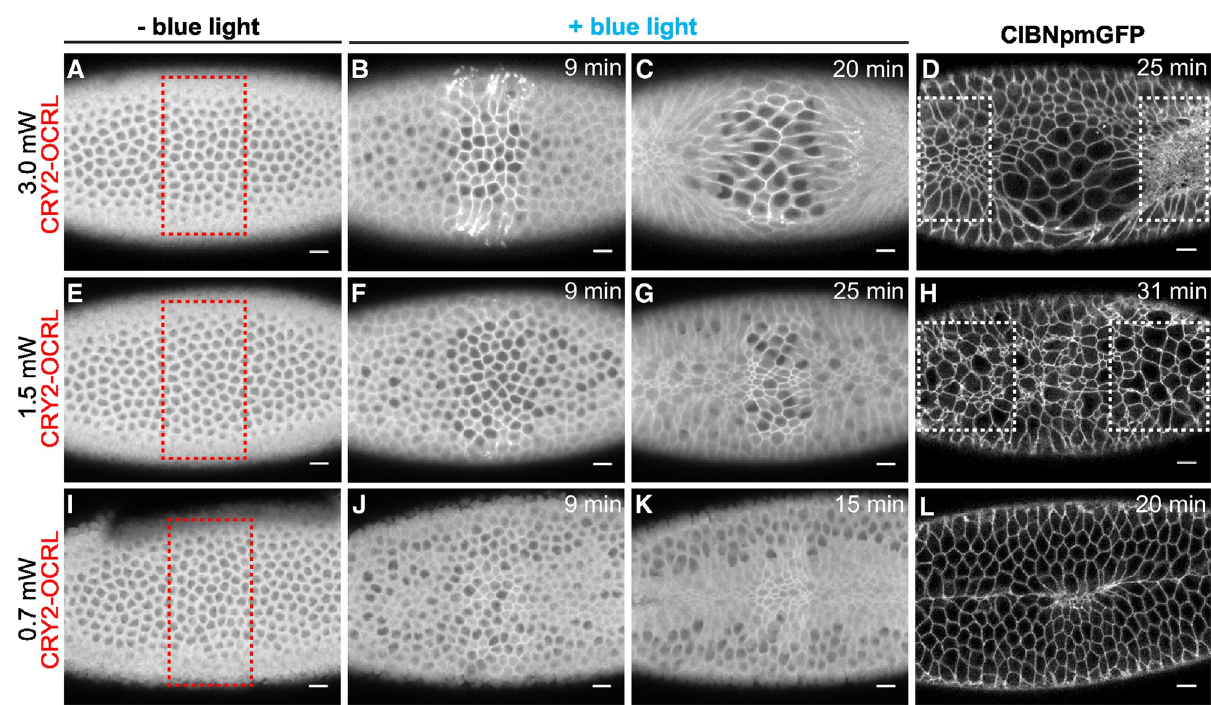
Fig 13. Confocal images of representative embryos with a zone of optogenetically reduced contractility. The apical surface of the ventral mesoderm is shown during the apical-constriction process. To locally reduce cell contractility, the embryos were exposed to blue light in the zone indicated by the red box in left panels. The affected zone was photoactivated with a ( A-D ) 3 mW, ( E-H ) 1.5 mW, and ( I-L ) 0.7 mW laser beam; the degree of cell contractility reduction is commensurate with the beam power. The first three images in each row are video frames from a confocal movie, and the last frame is a high-resolution confocal image. Time after photoactivation as indicated. For 0.7 mW and 1.5 mW laser power, the images show a significant number of constricted cells in the affected region, forming chain-like arrangements (E-L). Modified versions of (F-G) and (J-K) with constricted cells manually identified are provided as supplemental figures (S4 and S5 Figs). For the 3.0 mW laser power, constricted cells wrap around a large cluster of unconstricted (expanded) cells (A-D). Scale bars: 10 μ m. Figure reprinted from [25] under the article’s CC BY